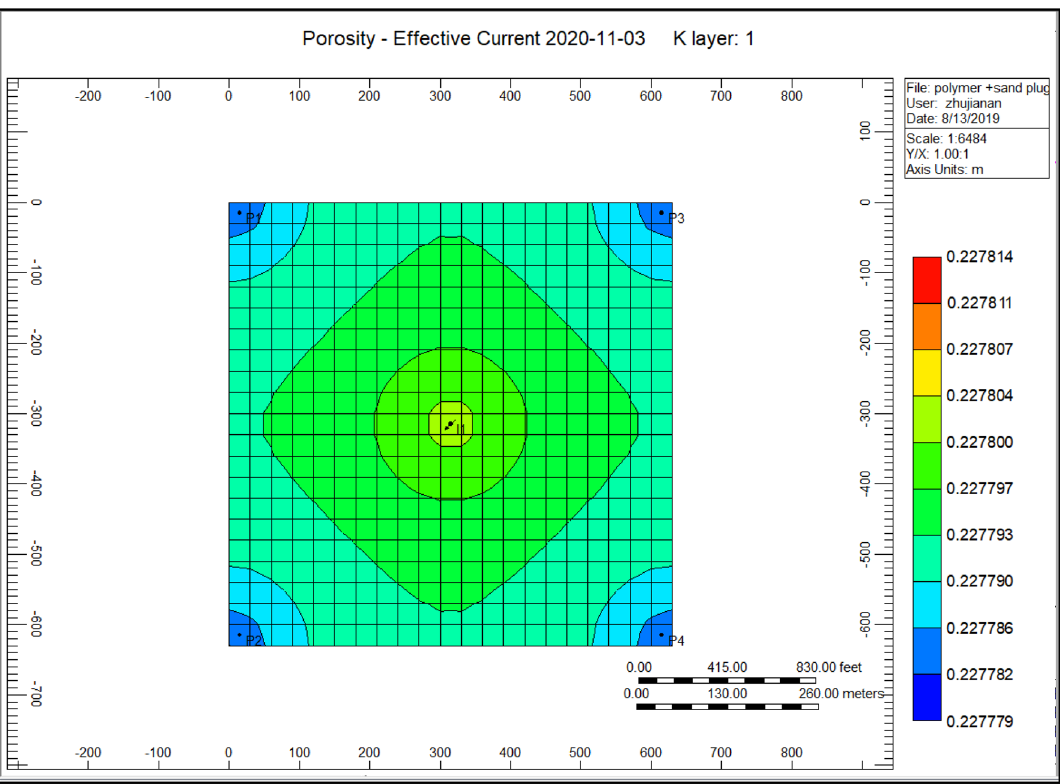
Figure 23. Indicates the porosity increased during the cross-linked gel performance 2020-11-03 CMG STARS 2017.10 URL: https:// www. cmgl.